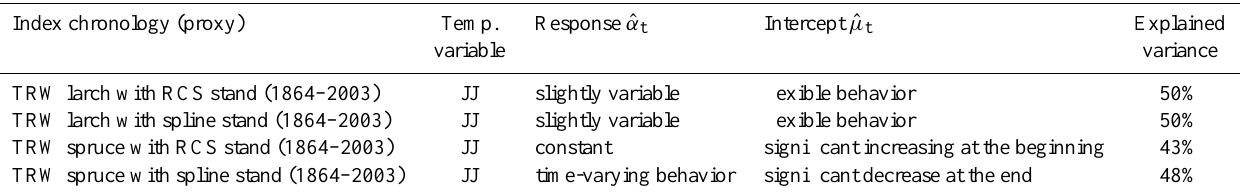
Table 2. Stability statistics for larch and spruce, based on two standardization approaches, RCS and splines. The stability descriptives are deduced from visual inspection of the SRF graphs, and were confirmed by LR